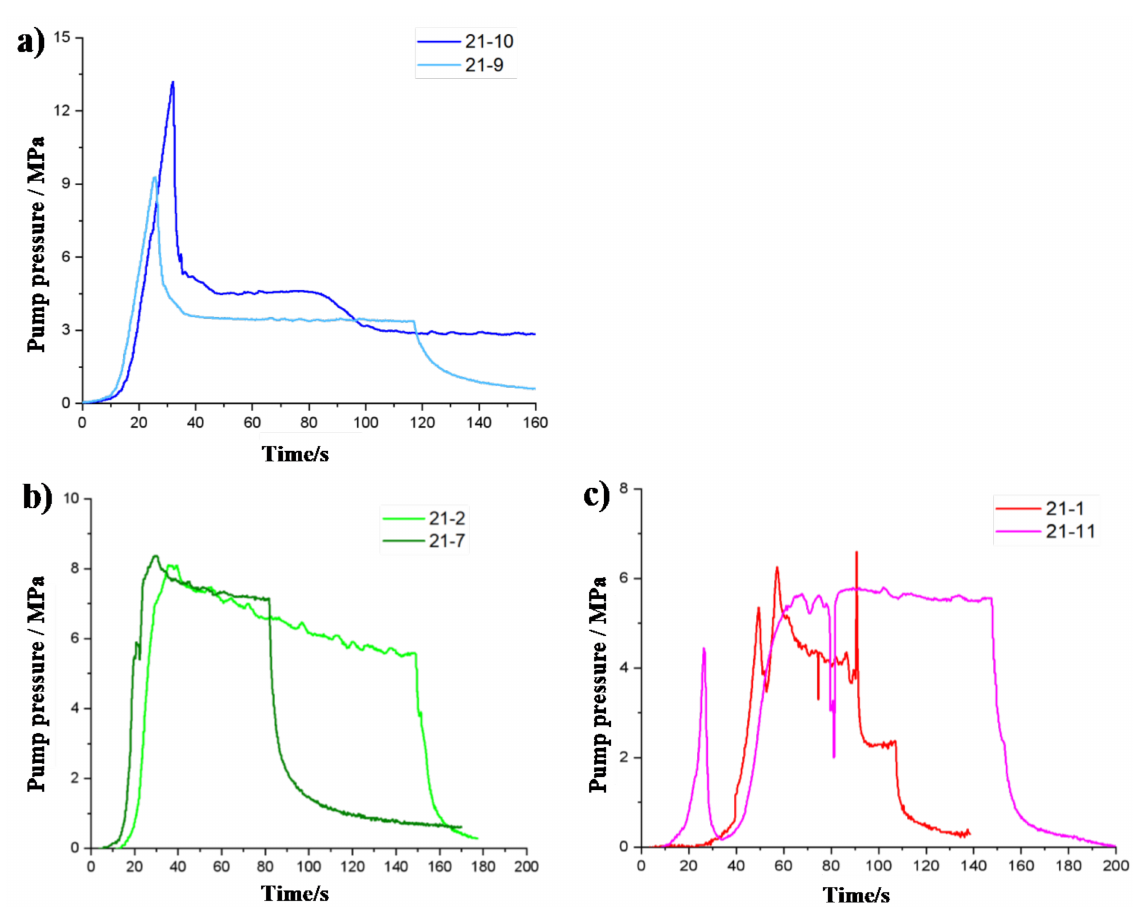
Figure 12. Pump pressure curves of the composite specimens: ( a ) Mode I samples, ( b ) Mode II samples and ( c ) Mode III